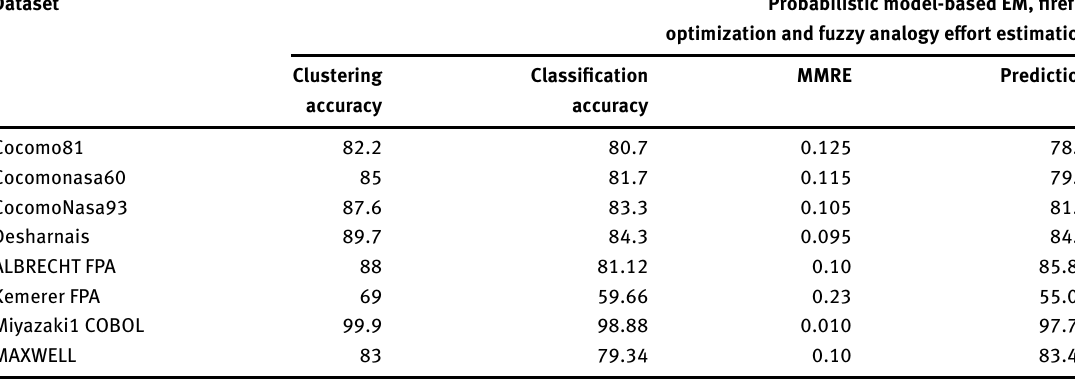
Table 5: Effort Estimation Using Expectation-Maximization (EM) Clusters, Firefly Optimization and Fuzzy Analogy. Dataset